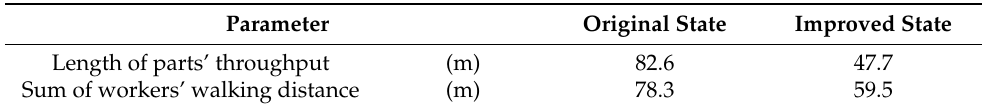
Table 1. Comparison of the original and improved state of the packing process.